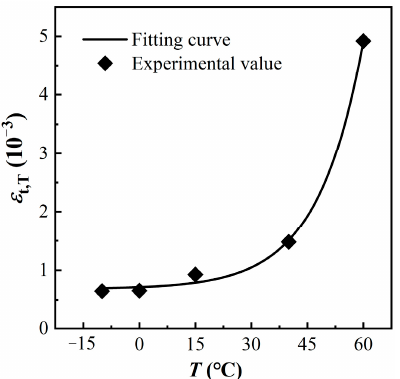
Figure 15. Relationship between tensile peak strain and temperature.